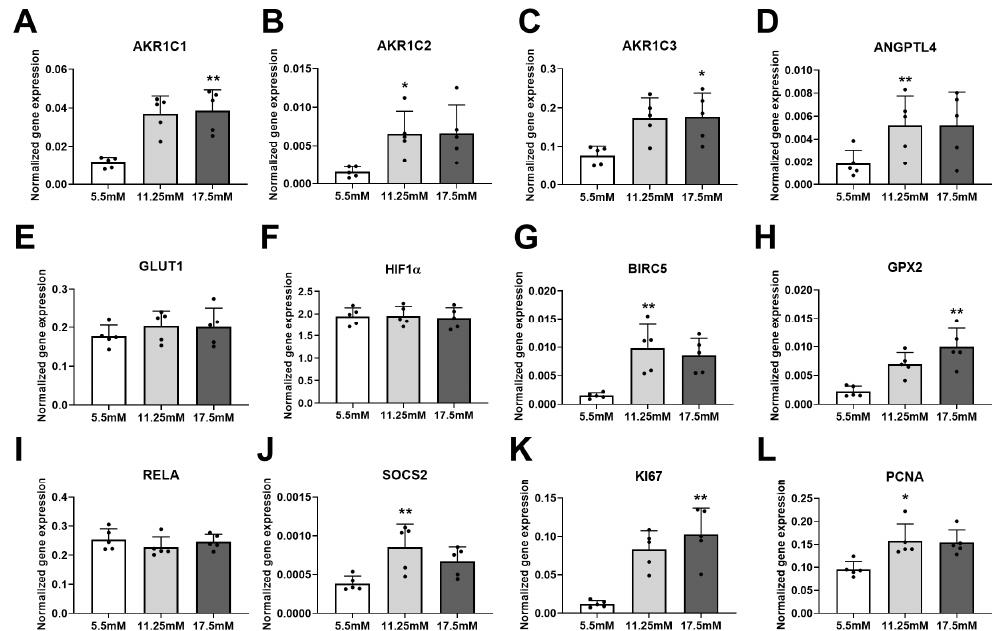
Figure 3. Gene expressions were measured in 5.5, 11.25, and 17.5 mM glucose-treated PC3 cells ( n = 5 independent experiments). Dots denote individual values. Statistical significance was compared to 5.5 mM control samples using a paired Friedman test with Dunn’s multiple comparisons. Statistical significance was considered as p < 0.05 and indicated as * p < 0.05 and ** p < 0.01.